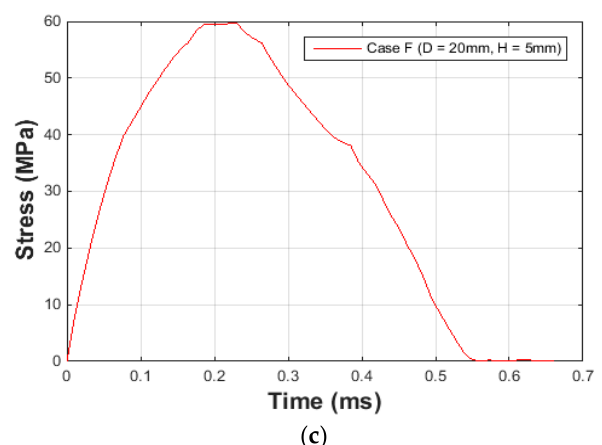
Figure 10. ( a ) Incident pulses generated from pulse shapers of various thickness with a striking velocity of 7.5 ms − 1 ( b ) Incident pulses generated from pulse shapers of various diameters with a striking velocity of 7.5 ms − 1 . ( c ) Hybrid copper and elastomeric pulse shaper.